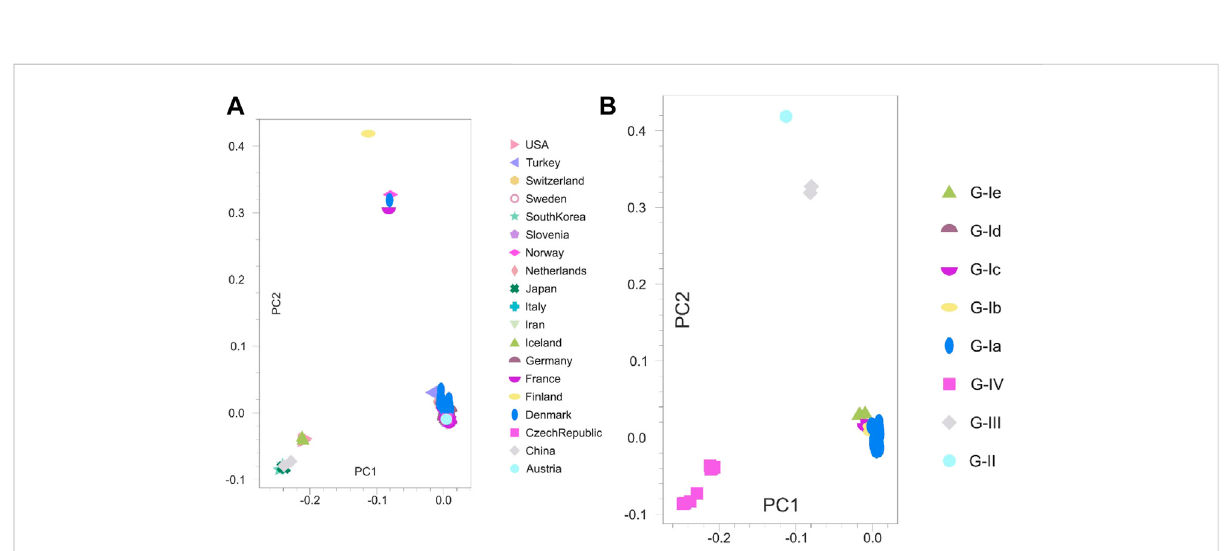
FIGURE 3 Principal component analysis (PCA). Two-dimensional PCA of VHSV G -gene. (A) Clustering of VHSV based on geography and country origin from where the samples are isolated. The Asian and United States samples together were observed to constitute a separate cluster at the left side from the European samples. (B) Genetic distinction of VHSV samples based on the reported genotypes. The genotype G-IV samples depict marked genetic distinction from the rest of the